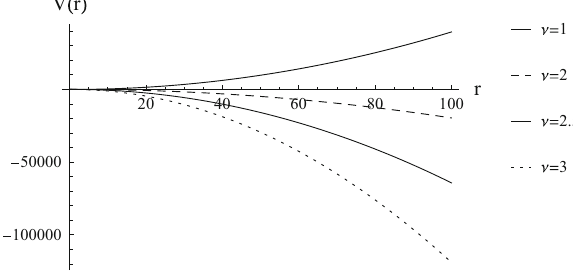
behavior of the effective potential between r = 0 and r = 3, while the right figure shows the